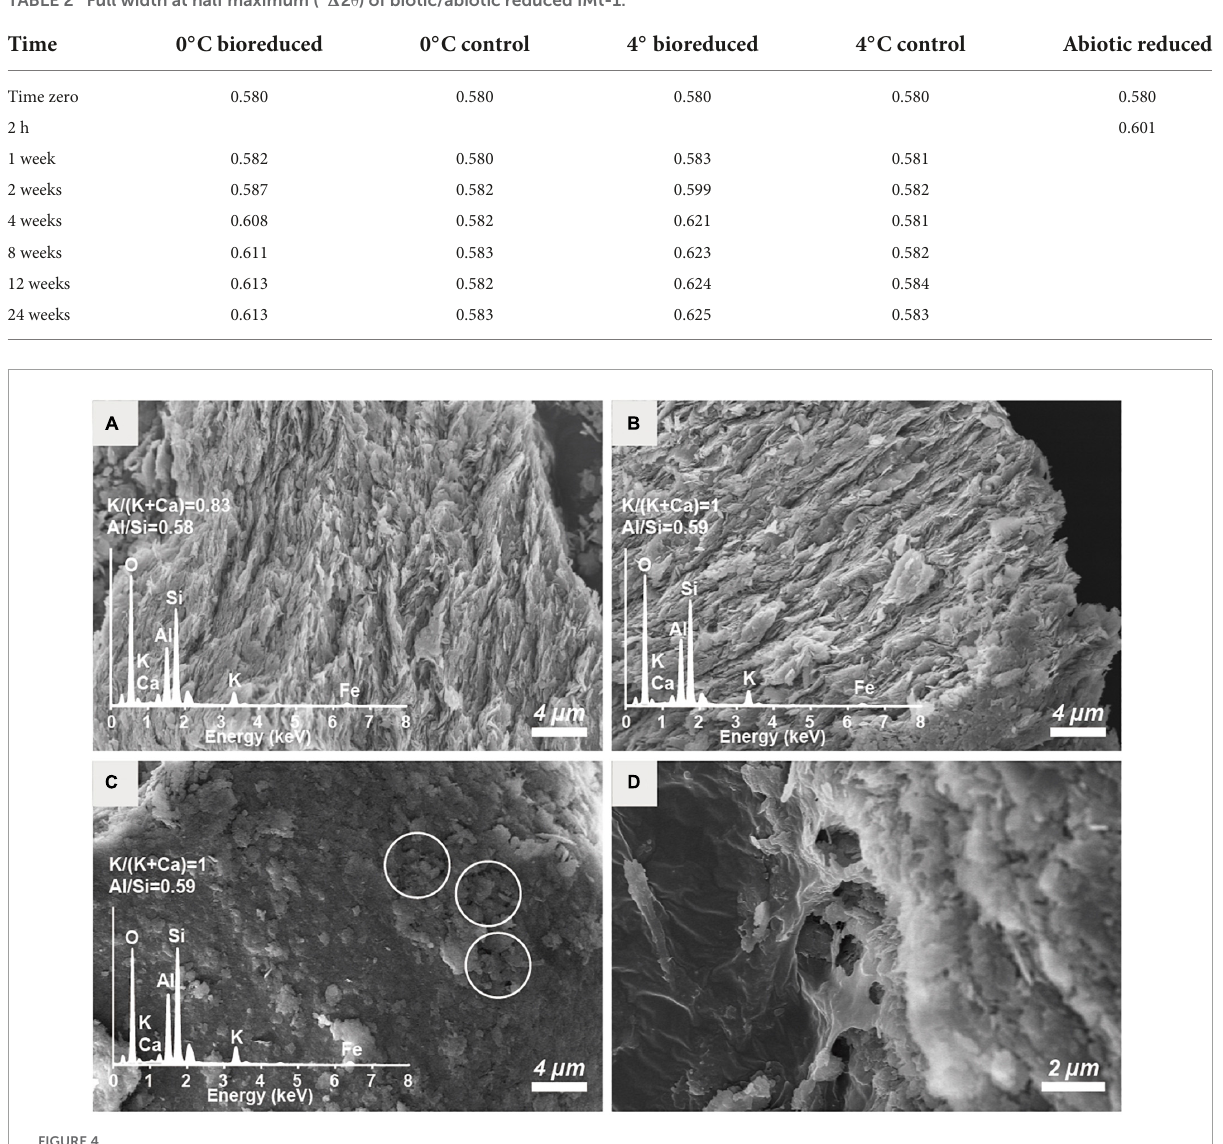
TABLE 2 Full width at half maximum ( ◦ (cid:49) 2 θ ) of biotic/abiotic reduced IMt-1.